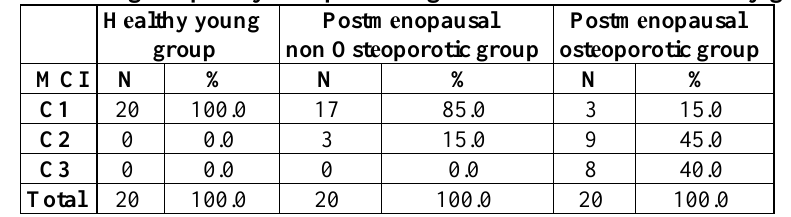
Tabl е 2: Showing fr е qu е ncy and p е rc е ntag е of MCI in diff е r е nt study groups.